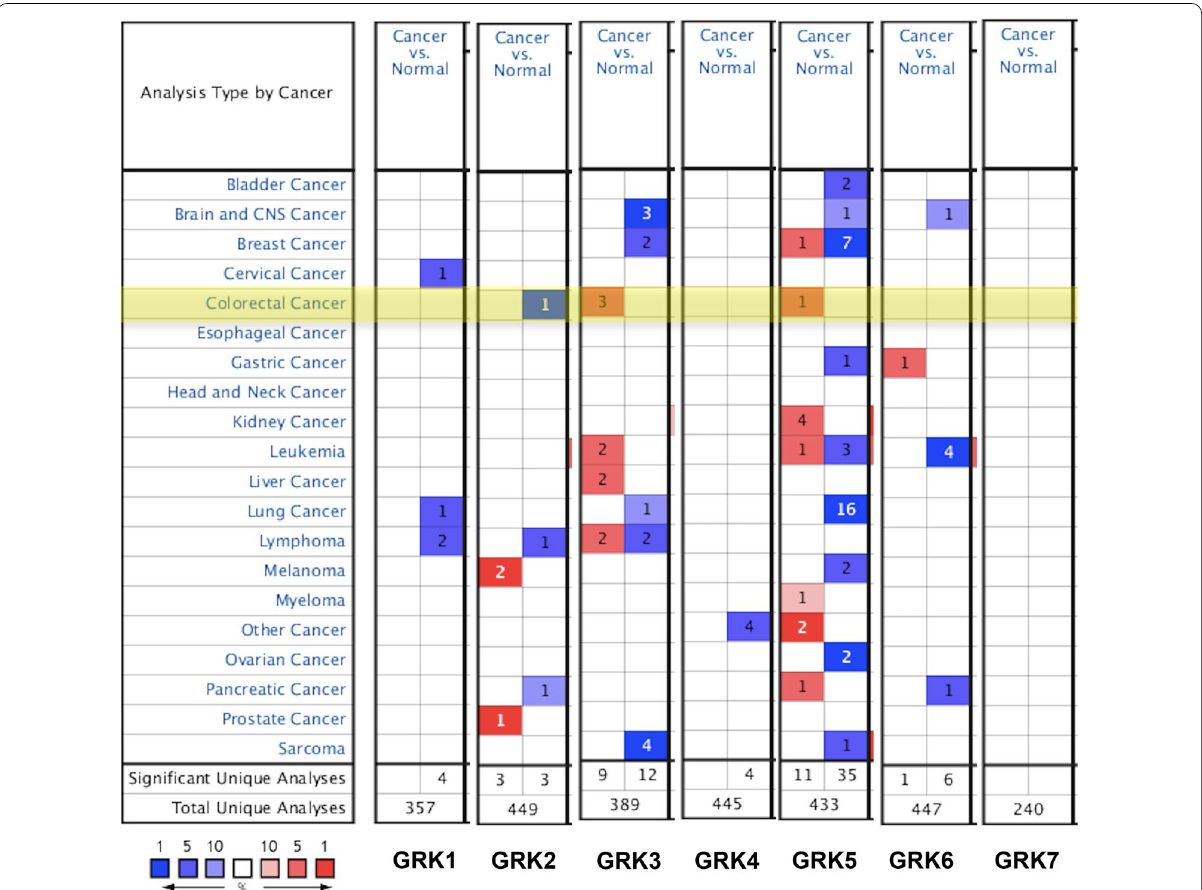
Fig. 1 Expression of GRK family across tumor versus adjacent tissues as analyzed by ONCOMINE. The selection criteria are fold change > 2 and p -value <